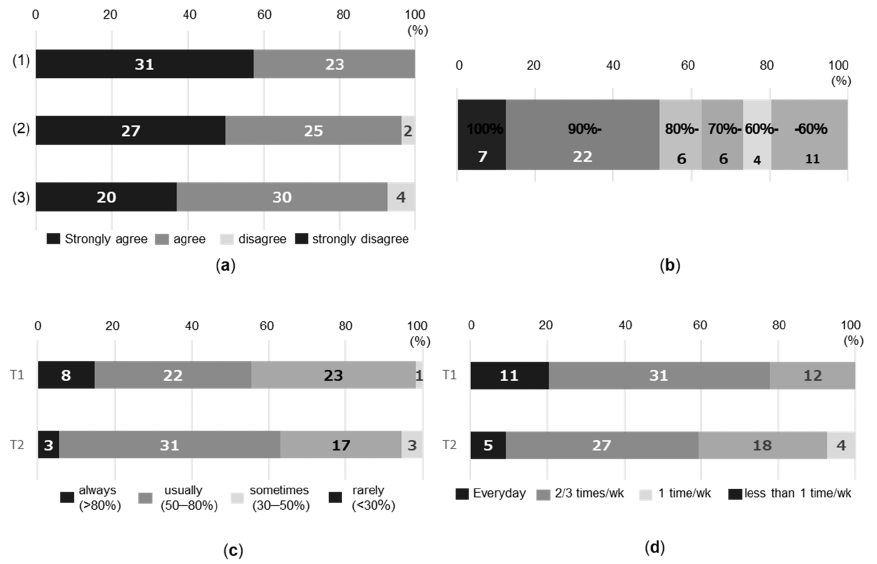
Figure 2. Acceptability and feasibility of the intervention ( n = 54). ( a ) Acceptability of the health guidance: Answers to the self-reported questions at T1 (Did you find the guidance easy to understand? Did you find the guidance useful for you? Did the guidance match what you thought you had to do?); ( b ) Device wearing rate: the percentage of the number of days the device was worn for more than 10 h per day during the intervention period (21–35 weeks of gestation (105 days)); and ( c ) Response rate to SB alerts: answers to the self-reported questions at T1 and T2; and ( d ) Frequency of self-monitoring: answers to the self-reported questions at T1 and T2. SB, sedentary behavior. Healthcare 2020 , 8 , x The cumulative time of light PA at T1 was lower in the intervention group than in the control group (243.4 ± 72.0 vs. 287.4 ± 77.1 min; p < 0.001), while there were no significant differences in other PA levels or SB at T1 between the two groups (Figure 3). There was no significant difference in the cumulative time of SB at T2 between the two groups, even using the T1 value as a covariate (560.9 ± 77.1 vs. 578.1 ± 57.6 min; F = 2.31; p = 0.132), while the cumulative time of light PA at T2 was significantly different between the two groups (234.0 ± 61.1 vs. 291.6 ± 92.4 min; F = 5.01; p = 0.028). were significantly earlier (39.3 ± 1.2 vs. 40.0 ± 1.0 weeks; t = − 2.92; p = 0.004) and the birth weight significantly lower (3026.2 ± 377.2 vs. 3189.2 ± 312.1 g; t = − 2.04; p = 0.04), while there were no significant differences in other delivery parameters between the two groups (Table 2).